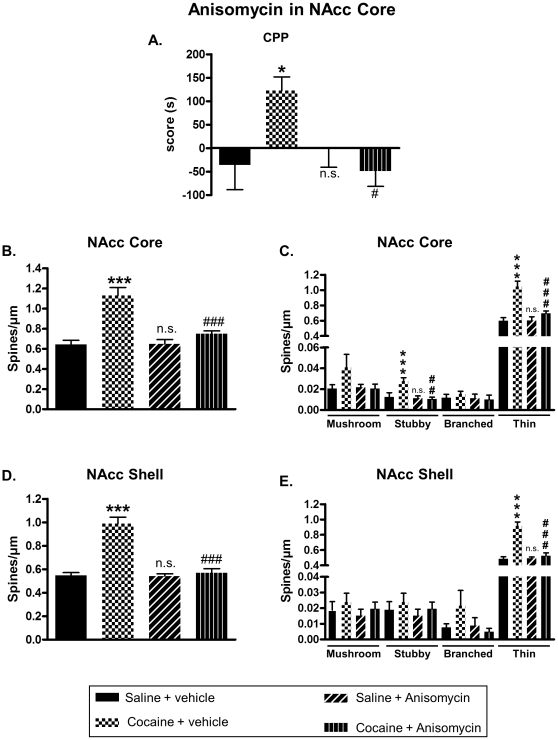
Anisomycin injection in the NAcc core blocks cocaine-induced CPP and neuroplasticity in the NAcc core and shell.CPP was induced in adult rats with saline or cocaine at 20 mg/kg. After each afternoon conditioning session, rats received intra-core infusion of anisomycin or vehicle. Immediately after the test, brains were processed for DeS analysis. CPP scores were expressed as the means ± S.E.M. (A) (Two-way ANOVA, Fcocaine(1,30) = 6.364, p = 0.18; Fanisomycin(1,30) = 2.851, p = 0.101; Fcocaine × anisomycin = 6.364, p<0.05). Total DeS density was expressed as spines/µm (mean ± S.E.M.) in MSN from the NAcc core (B) (Two-way ANOVA, Fcocaine(1,30) = 36.03, p<0.001; Fanisomycin(1,30) = 14.86, p<0.001; Fcocaine × anisomycin = 15.51, p<0.001) and shell (D) (Two- way ANOVA, Fcocaine(1,30) = 48.46, p<0.001; Fanisomycin(1,30) = 39.31, p<0.001; Fcocaine × anisomycin = 37.72, p<0.001). Density of mushroom, stubby, branched or thin spines was expressed as spines/µm (mean ± S.E.M.) in MSN from the NAcc core (C) (Two-way ANOVA mushroom, Fcocaine(1,30) = 2.636, p = 0.114; Fanisomycin(1,30) = 2.096, p = 0.158; Fcocaine × anisomycin = 3.405, p = 0.074; Two-way ANOVA stubby, Fcocaine(1,30) = 5.852, p<0.05; Fanisomycin(1,30) = 9.828, p<0.05; Fcocaine × anisomycin = 6.994, p<0.05; Two-way ANOVA branched, Fcocaine(1,30) = 0.081, p = 0.776; Fanisomycin(1,30) = 0.626, p = 0.434; Fcocaine × anisomycin = 0.419, p = 0.522; Two-way ANOVA thin, Fcocaine(1,30) = 33.43, p<0.001; Fanisomycin(1,30) = 13.75, p<0.001; Fcocaine × anisomycin = 14.33, p<0.001) and shell (E) (Two-way ANOVA mushroom, Fcocaine(1,30) = 0.574, p = 0.454; Fanisomycin(1,30) = 2.215, p = 0.147; Fcocaine × anisomycin = 0.03, p = 0.861; Two-way ANOVA stubby, Fcocaine(1,30) = 0.944, p = 0.338; Fanisomycin(1,30) = 0.62, p = 0.426; Fcocaine × anisomycin = 0.004, p = 0.949; Two-way ANOVA branched, Fcocaine(1,30) = 0.942, p = 0.339; Fanisomycin(1,30) = 2.319, p = 0.138; Fcocaine × anisomycin = 3.028, p = 0.092; Two-way ANOVA thin, Fcocaine(1,30) = 44.43, p<0.001; Fanisomycin(1,30) = 30.71, p<0.001; Fcocaine × anisomycin = 32.67, p<0.001). * p<0.05; *** p<0.001; n.s. (not significant) vs Saline + vehicle group; # p<0.05; ### p<0.001 vs Cocaine + vehicle group, Bonferroni post-hoc test, n = 7 to 9 animals/group.